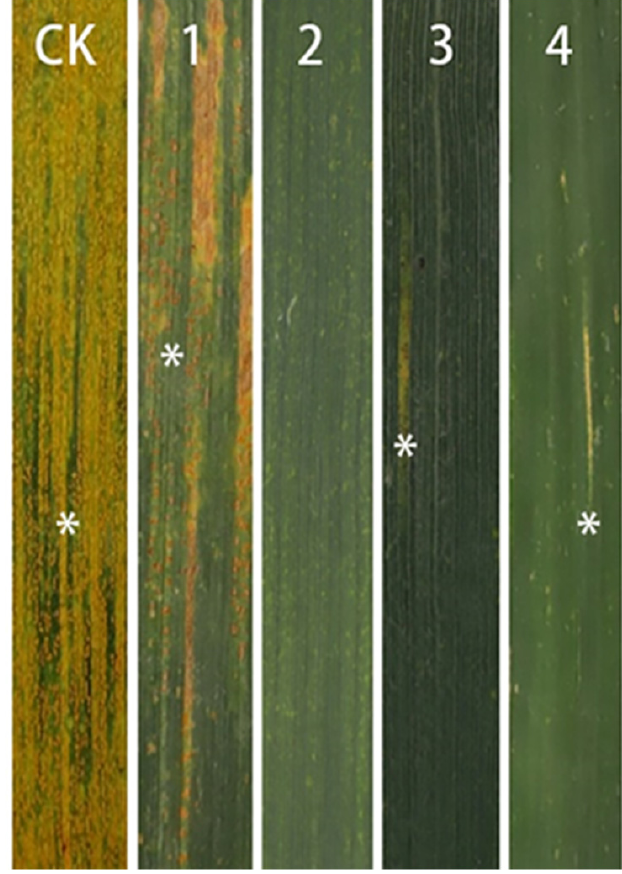
Figure 5. Stripe rust disease reaction of 17DM48 and its parents. (CK) Triticum aestivum Huixianhong. ( 1 ) T. aestivum cv. 7182. ( 2 ) octoploid Tritileymus M842. ( 3 ) T. durum D4286. ( 4 ) disomic substitution line 17DM48. Asterisks indicate the symptoms and types of stripe rust reaction.